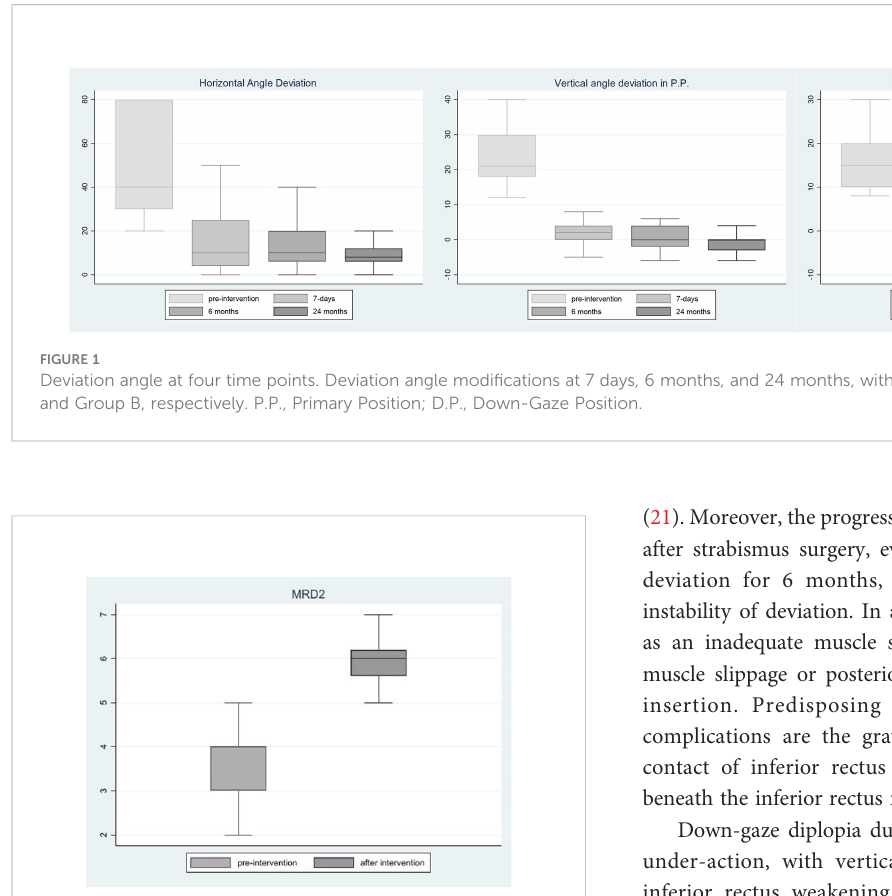
FIGURE 2 MRD2. MRD2 changes 6 months after surgery in Group B. MRD2: Margin Re fl ex Distance - 2.